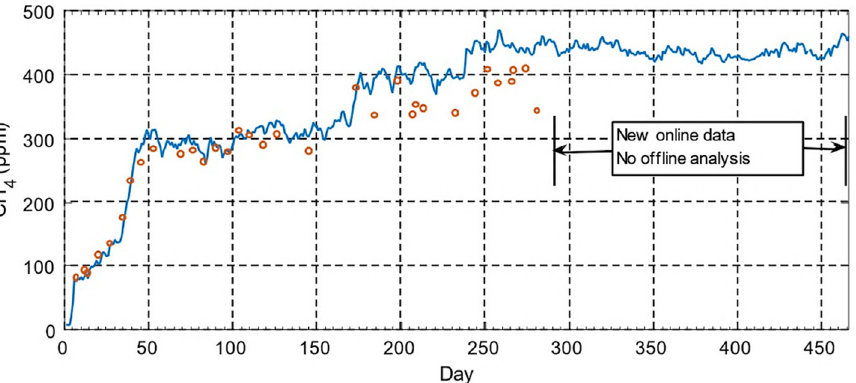
Figure 53. Evolution of methane concentration over time, online (blue) and offline (orange) data.